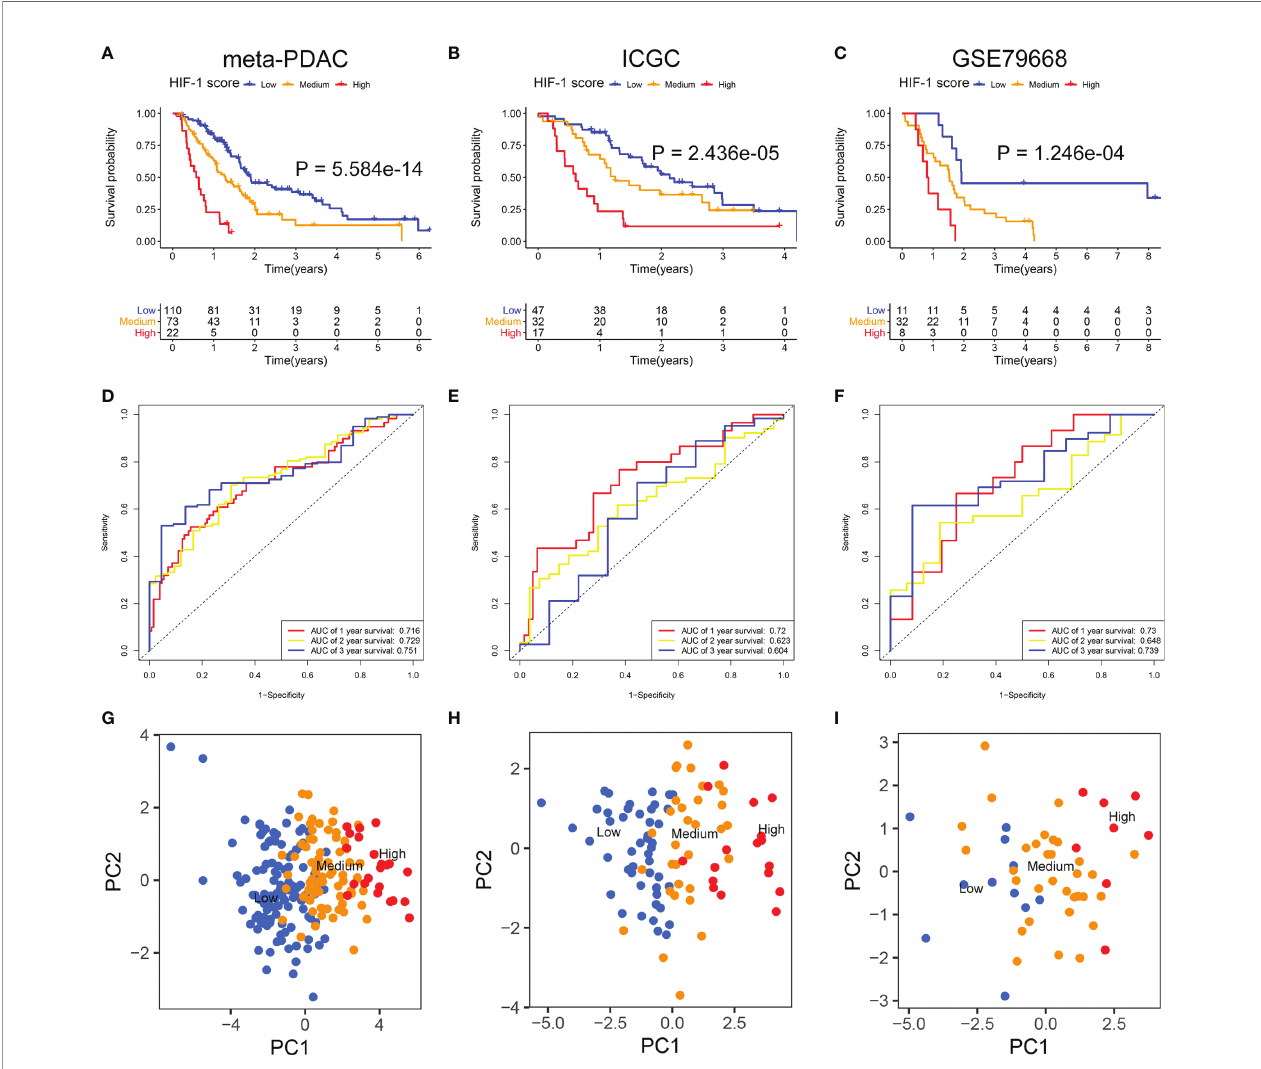
FIGURE 3 | Development and validation of the HIF-1 score system. (A – C) KM survival curves for OS of patients with PDAC according to the HIF-1 score groups in the meta-PDAC cohort, ICGC PDAC cohort, and GSE79668 cohort. (D – F) ROC curve analysis of the HIF-1 score system for 1-, 2-, and 3-year OS prediction in the meta-PDAC cohort, ICGC PDAC cohort, and GSE79668 cohort. (G – I) PCA to con fi rm the cluster ef fi cacy of the HIF-1 score system in the meta-PDAC cohort, ICGC PDAC cohort, and GSE79668 cohort. KM, Kaplan-Meier; OS, overall survival; PDAC, pancreatic ductal adenocarcinoma; PCA, principal component analysis; ROC, the receiver operating characteristic